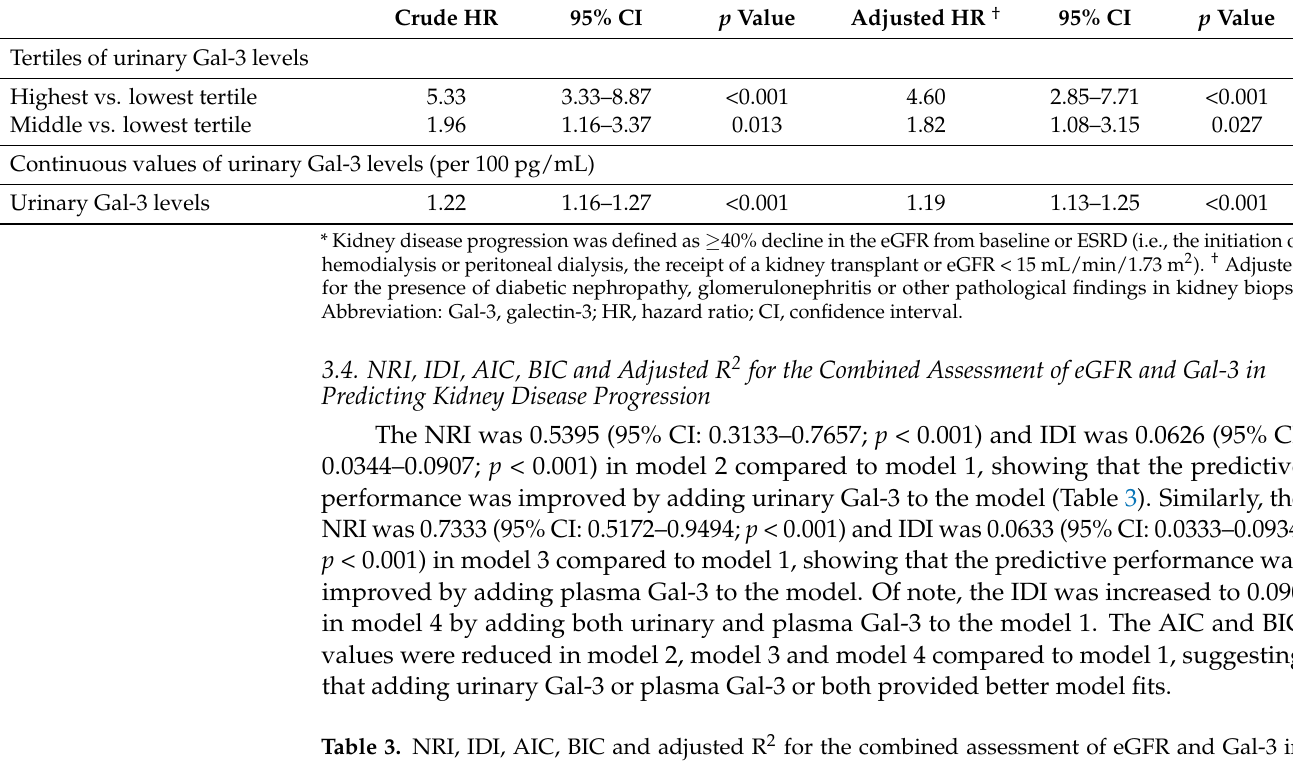
Table 3. NRI, IDI, AIC, BIC and adjusted R 2 for the combined assessment of eGFR and Gal-3 in predicting kidney disease